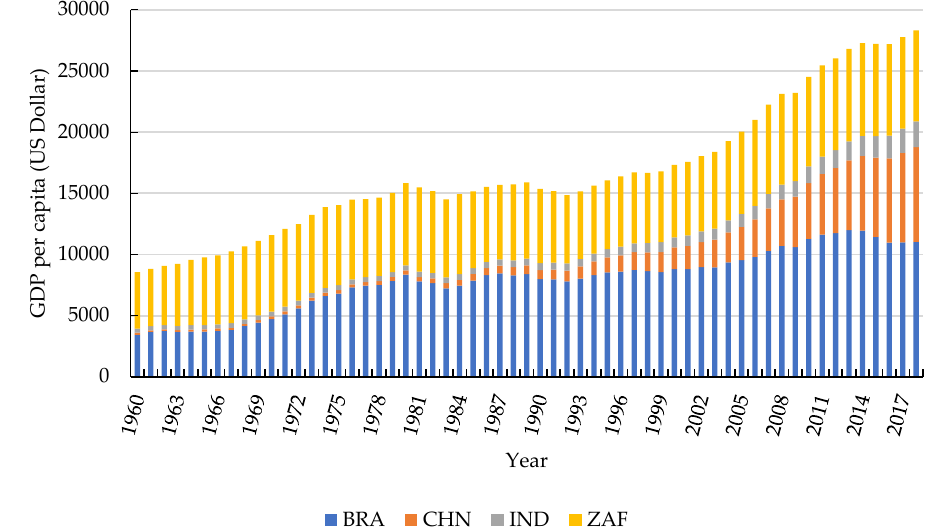
Figure 1. Per capita gross domestic product (GDP) trends of the BRICS countries from 1960 to 2018. (Source: World Bank. BRA stands for Brazil, CHN stands for China, IND stands for India, ZAF stands for South Africa.)